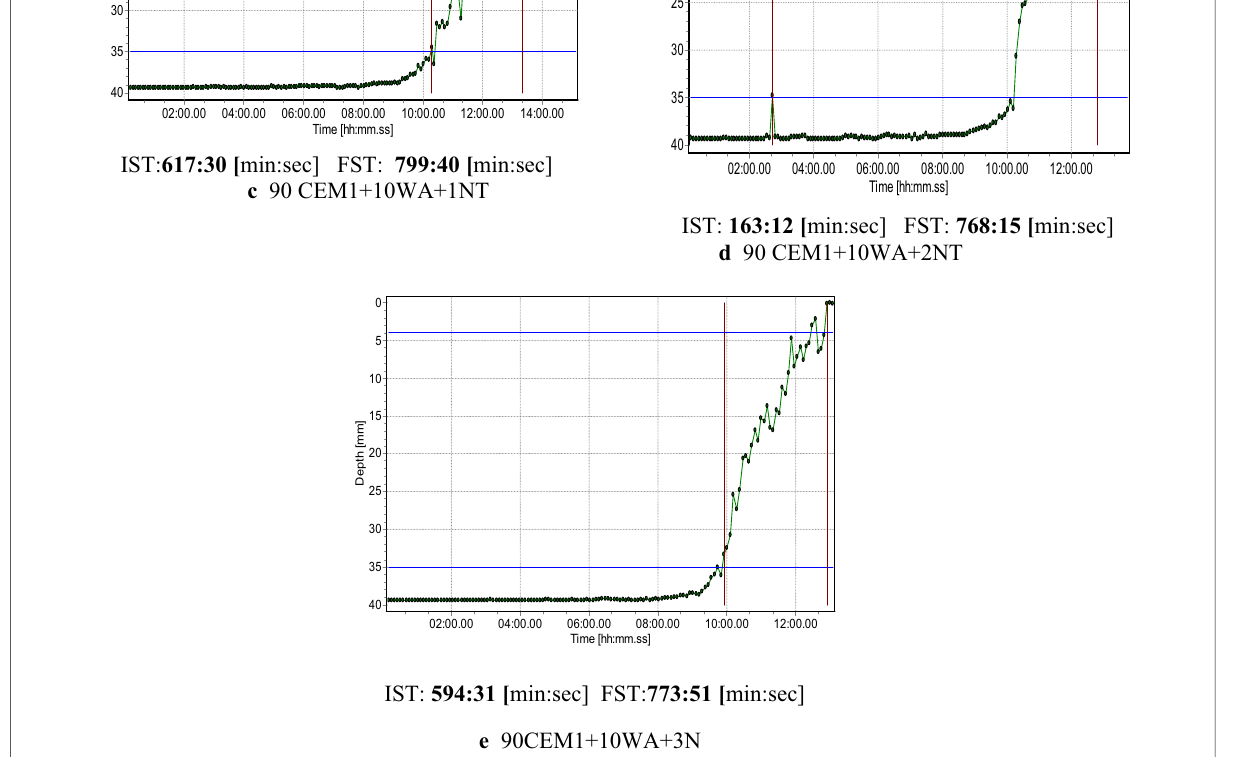
Fig. 3 Setting times of cement mortar incorporating WA and